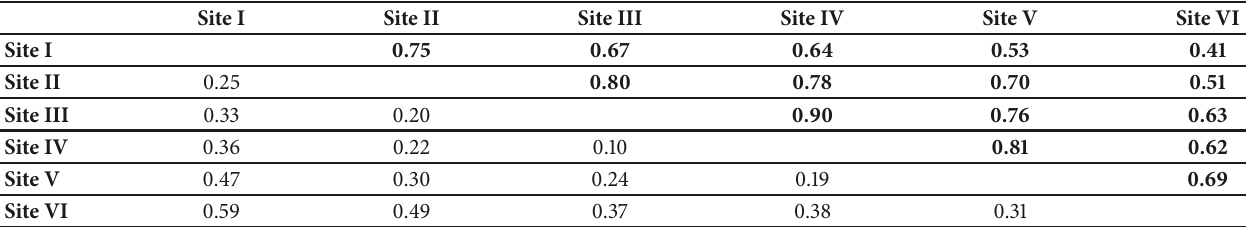
Table 17: Index of similarity and dissimilarity among different sites for Radha Krishna